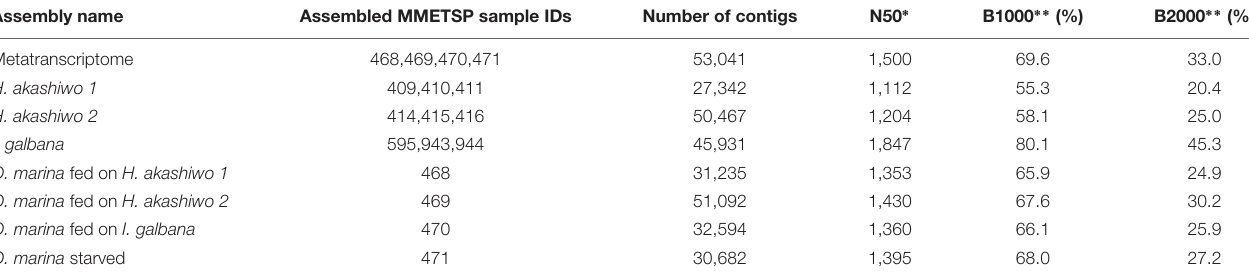
TABLE 2 | Transcriptome assembly